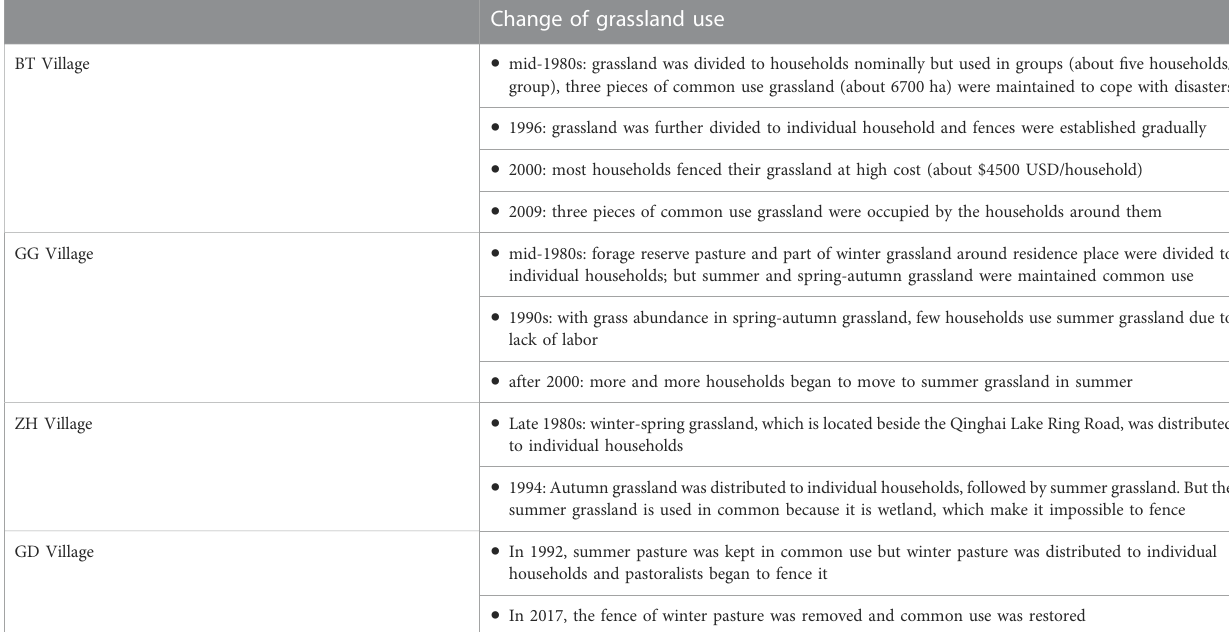
TABLE 3 Change of grassland use of four cases.